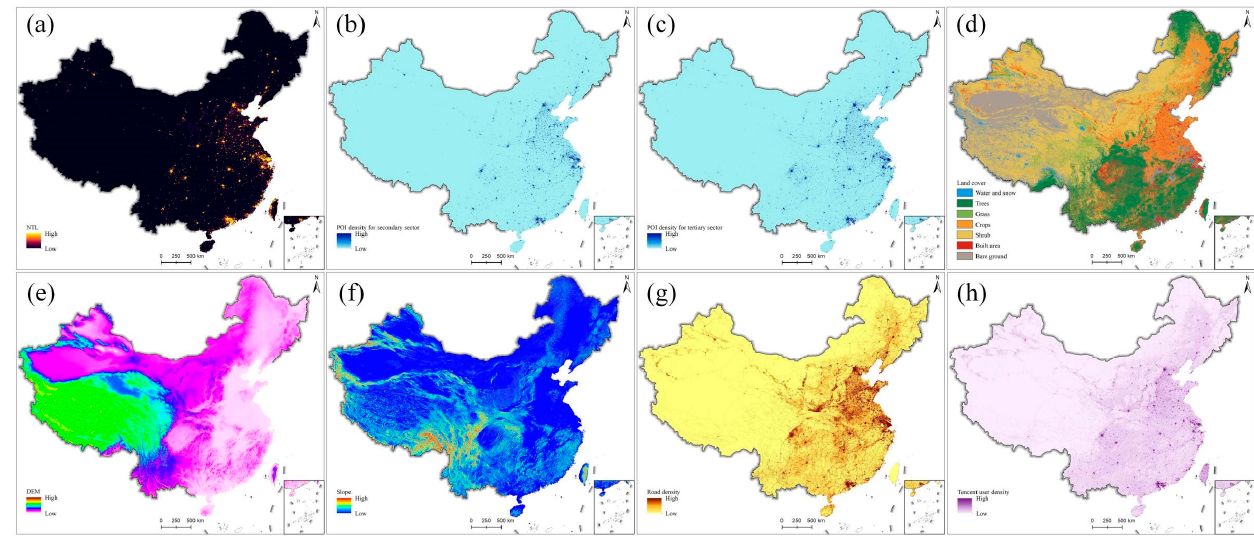
Figure 2. The 1 km gridded covariates of China: ( a ) NTL, ( b ) POI density for the secondary sector,